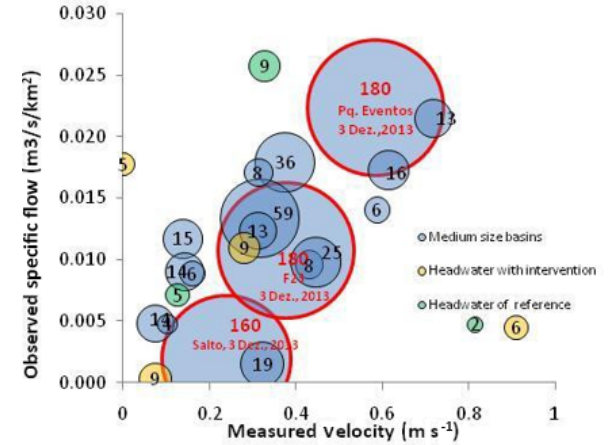
Figure 6. Experimental sampling of turbidity (size of circles), ob- served flows and mean velocities in river cross sections of 17 catch- ments in Cantareira system headwater (October 2013–May 2014). This illustration shows the high interdependence and complexity in integrating any standard parameterization, at a regional scale, of the SWAT model, linking potential scenarios of LULC, water yield and freshwater quality in medium-size basins and